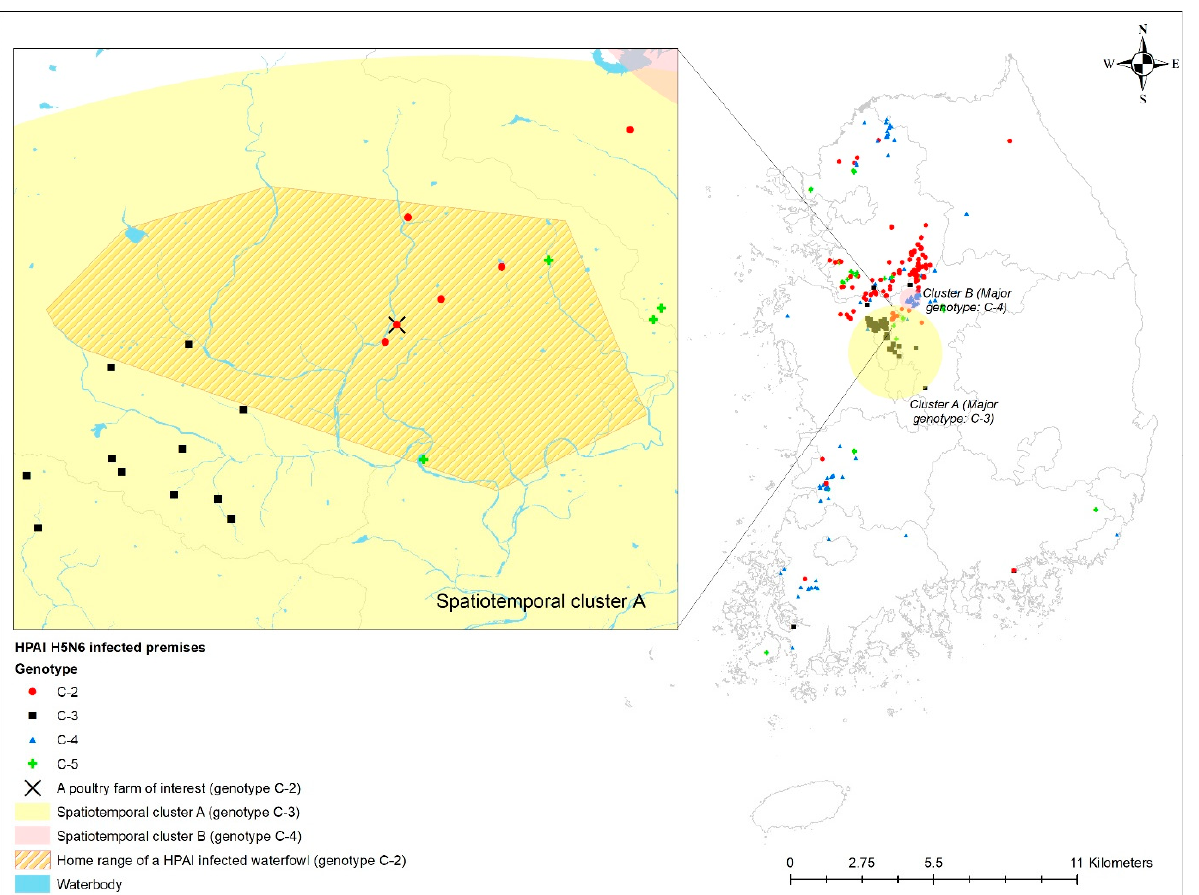
Figure 4. Geographical distribution of the home range of highly pathogenic avian influenza (HPAI) virus-infected premises by genotype, together with spatiotemporal clusters. Enlarged map for the infected chicken farm located in the HPAI-infected waterfowl’s home range.